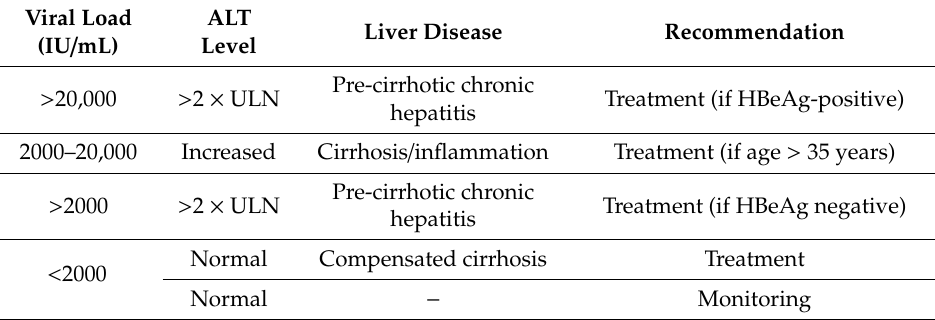
Table 5. APASL treatment indications for chronic HBV-infected